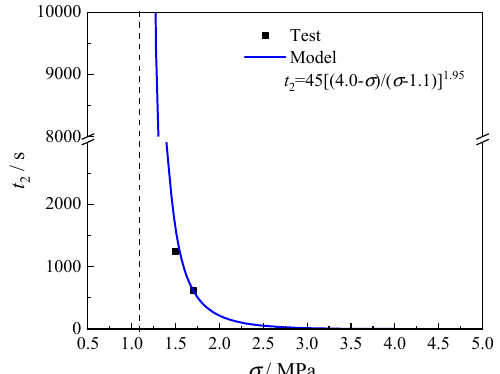
Figure 10. Damage incubation time as a function of creep stress.